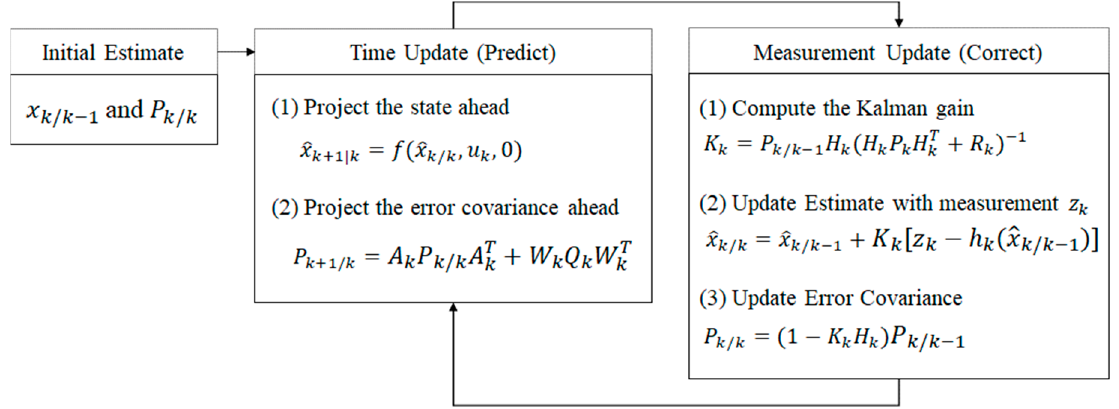
Figure 4. Positioning process with extended Kalman filter.